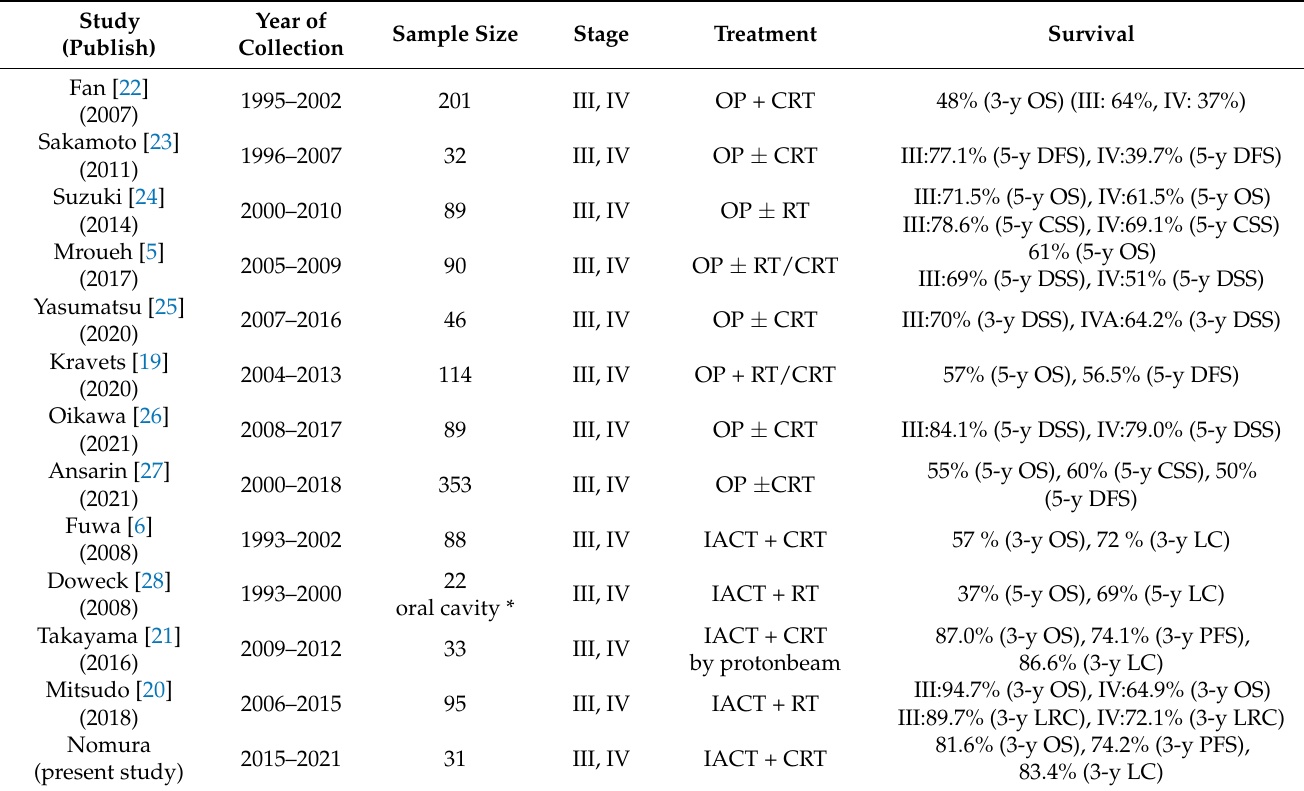
Table 5. Summary of treatment outcomes of patients with locally advanced tongue